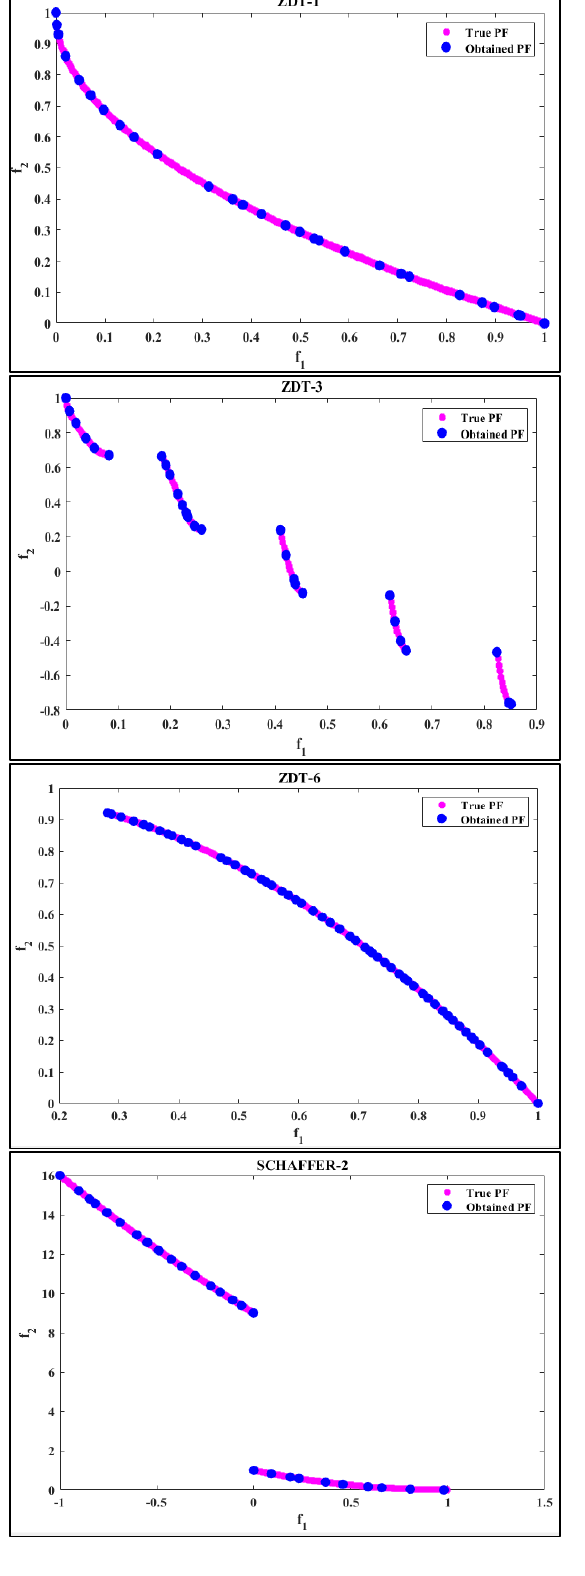
Figure 12. Best Pareto optimal front obtained of unconstrained test functions by MOGNDO